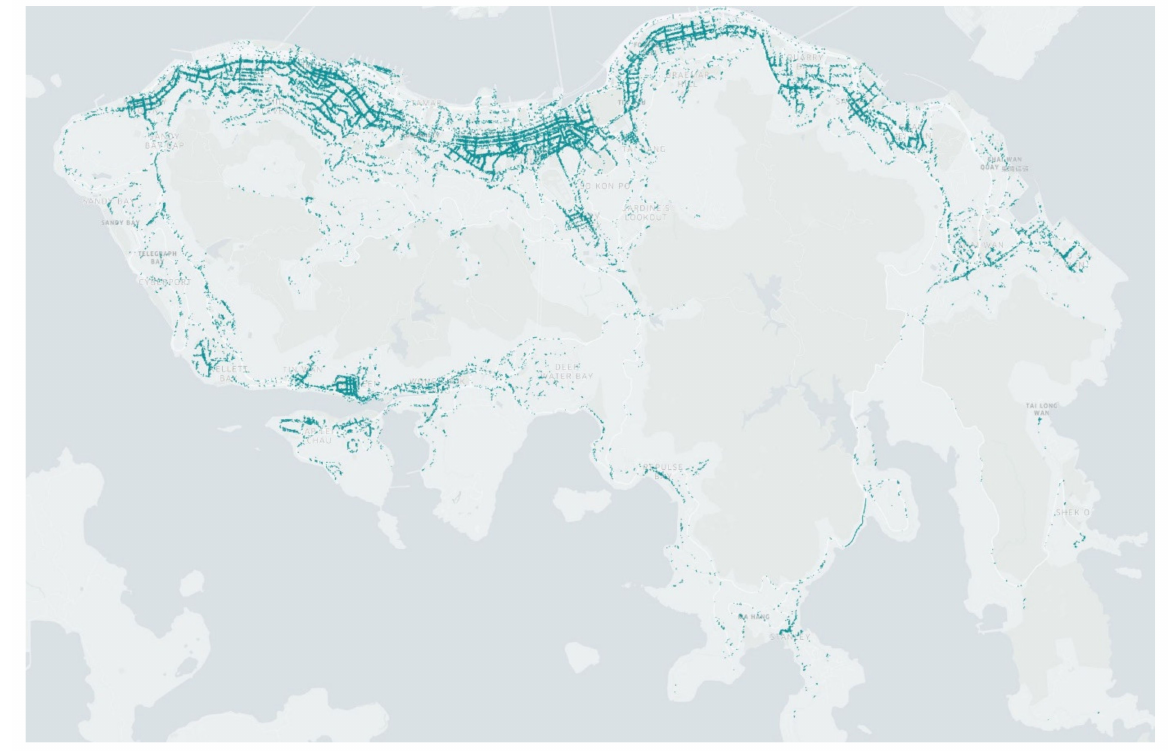
Figure 8. Geospatial distribution of 61,788 pedestrians detected in 530,000 TSV photographs.